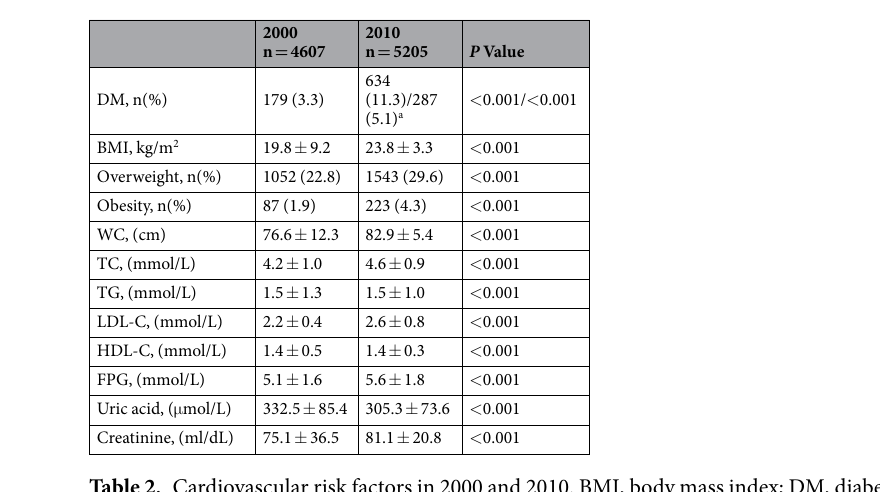
Table 2. Cardiovascular risk factors in 2000 and 2010. BMI, body mass index; DM, diabetes mellitus; FPG, fasting plasma glucose; HDL-C, high density lipoprotein cholesterol; LDL-C, low-density lipoprotein cholesterol; TC, total cholesterol; TG, triglycerides; WC, waist circumference. Data are presented as mean ± standard deviation (m ± s) for continuous variables and as frequencies (percentages) for categorical variables. Statistical comparisons are from Pearson chi square tests for categorical variables and one way ANOVA for continuous variables. Diabetes was diagnosed by fast glucose in 2000 and by the oral glucose tolerance test in 2010. a The prevalence of diabetes according to the fast glucose in 2010 was